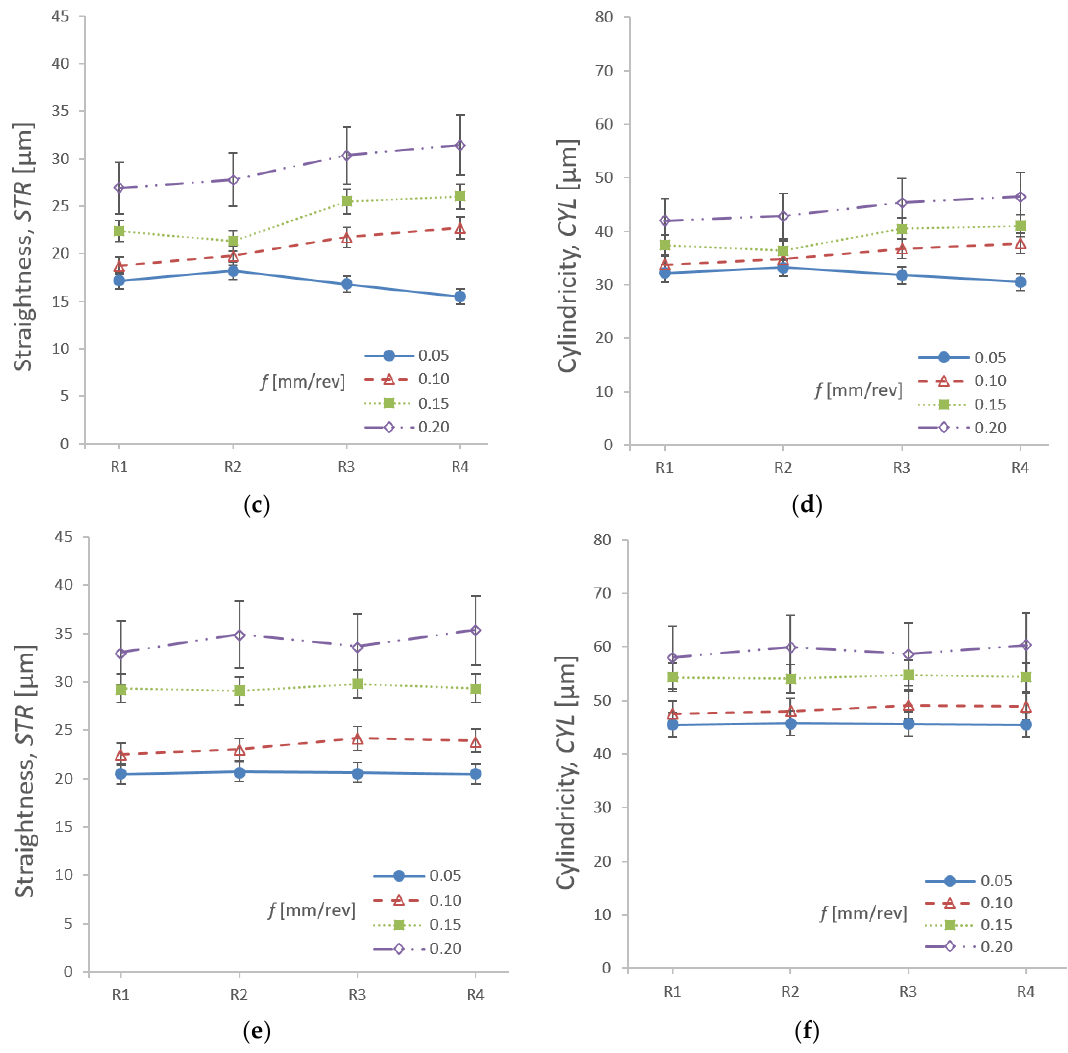
Figure 15. Straightness and cylindricity evolution for each repetition ( Ri ) as a function of f , for: ( a ), ( b ) v c = 40 m/min; ( c ), ( d ) v c = 60 m/min; ( e ), ( f ) v c = 80 m/min.